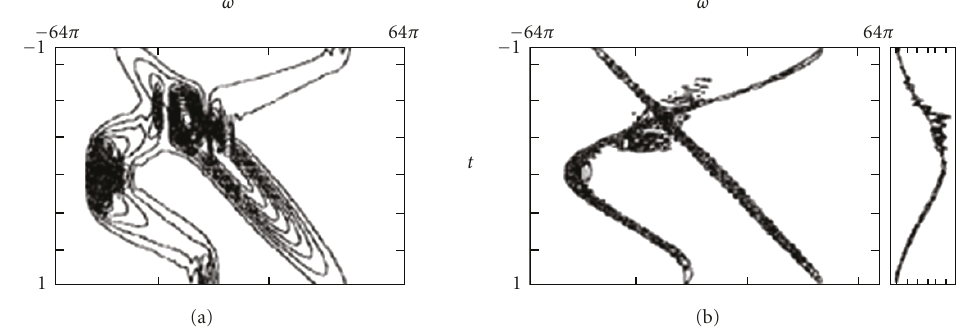
Figure 8: TFD of a multicomponent signal whose components intersects: (a) spectrogram, (b) S-distribution with L = 2 (adopted from Stankovi´c